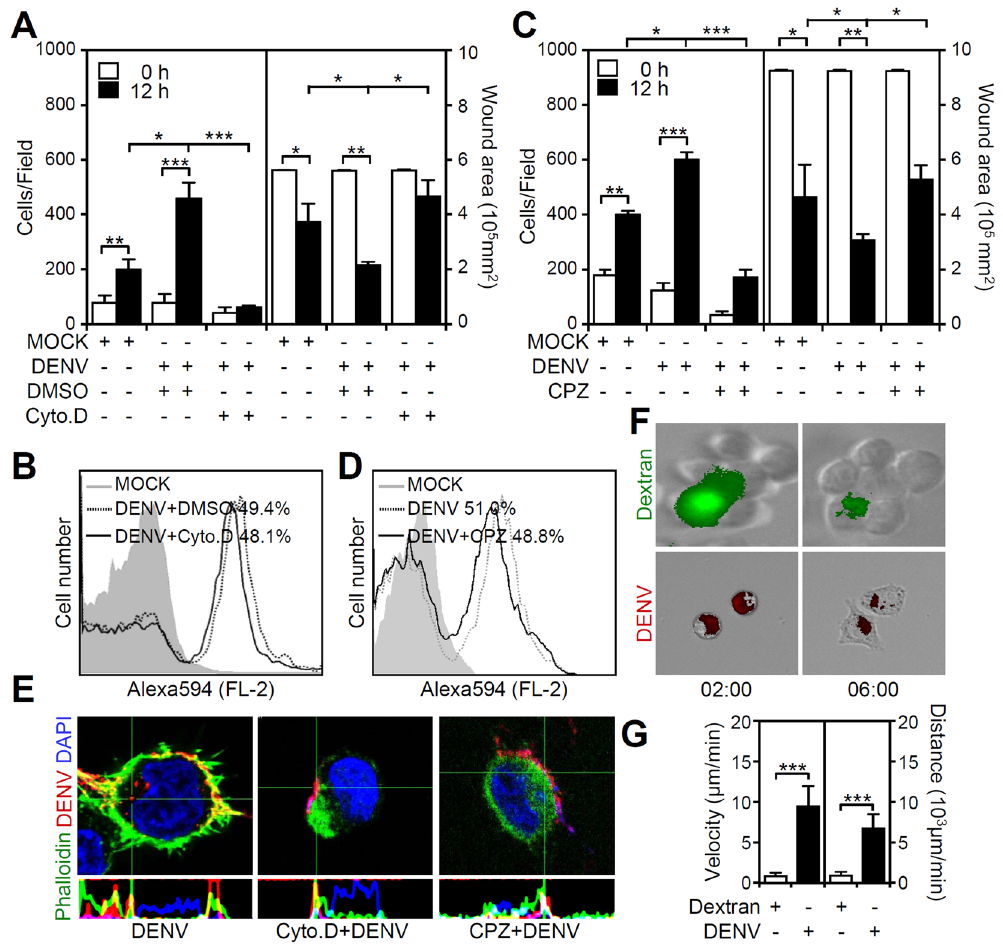
Figure 4. Inhibition of actin polymerization and clathrin-mediated endocytosis reduce the DENV-induced increase in microglial migration. BV2 cells were inoculated with ( A and C ) DENV 2 (MOI = 50) or ( B and D ) Alexa-594-labeled DENV 2 (MOI = 50) for 12 h in the presence of the actin polymerization inhibitor cytochalasin D (Cyto. D, 5 µ M) and the clathrin inhibitor chlorpromazine (CPZ, 10 µ g/ml). The numbers of migrated cells and wound area measurements showed cell migration. Flow cytometry were used to measure the percentage of microglial cells carrying fluorescent DENV. ( E ) Furthermore, confocal microscopy showed the binding/entry of Alexa-594-labeled DENV 2 (MOI = 50, red ) in BV2 cells with or without Cyto. D and CPZ. Phalloidin ( green ) staining indicated actin. DAPI staining indicated the nuclei ( blue ). ( F ) BV2 cells were treated with dextran ( green ) or Alexa-594-labeled DENV 2 ( red , MOI = 50) for 6 h. The time-lapsed images showed cell morphology changes. ( G ) Migrating cell tracking showed the velocity and distance of the migrated cells. For all images, representative data were selectively obtained from three individual experiments. The quantitative data are depicted as the means ± SD. * p < 0.05, ** p < 0.01, and *** p < 0.001. ns, not